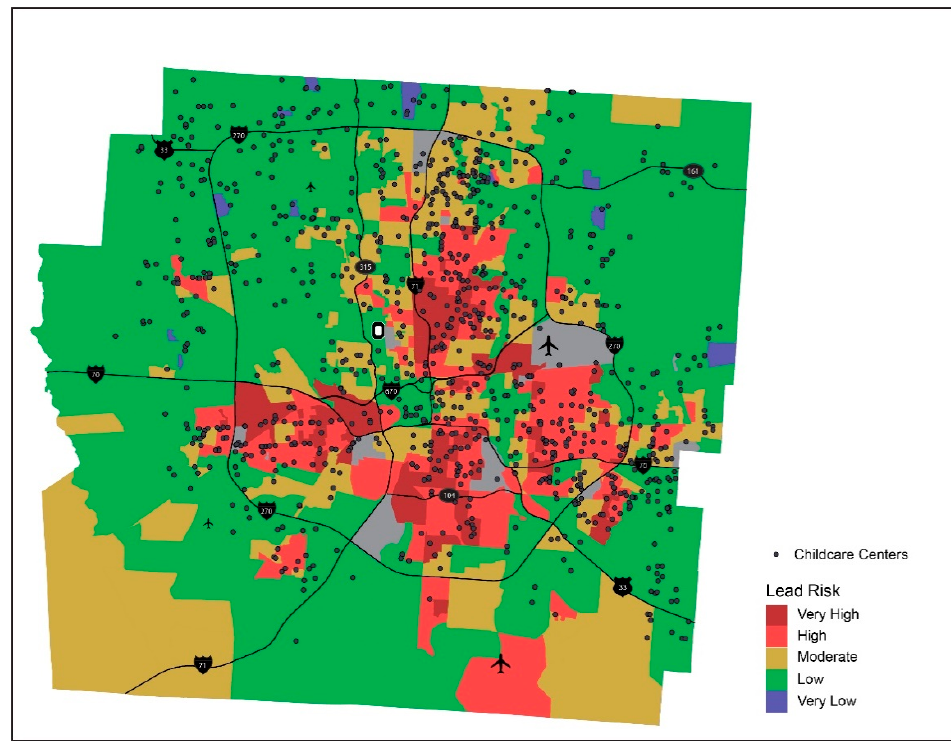
Figure 12. Lead risk and childcare centers. Table 5 . Childcare centers by lead risk level .